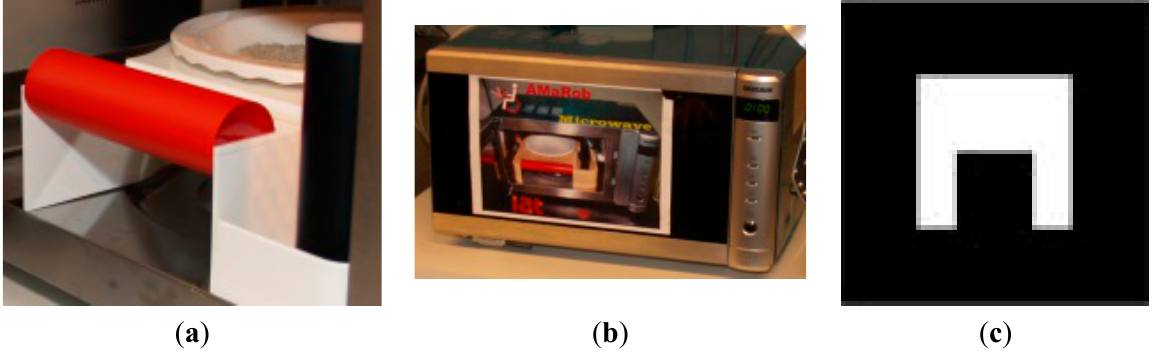
Figure 4. Marker layout used to distinguish between home devices, object with specific color and size as marker ( a ), object to be recognized by SIFT ( b ) and artificial ARToolKit marker ( c